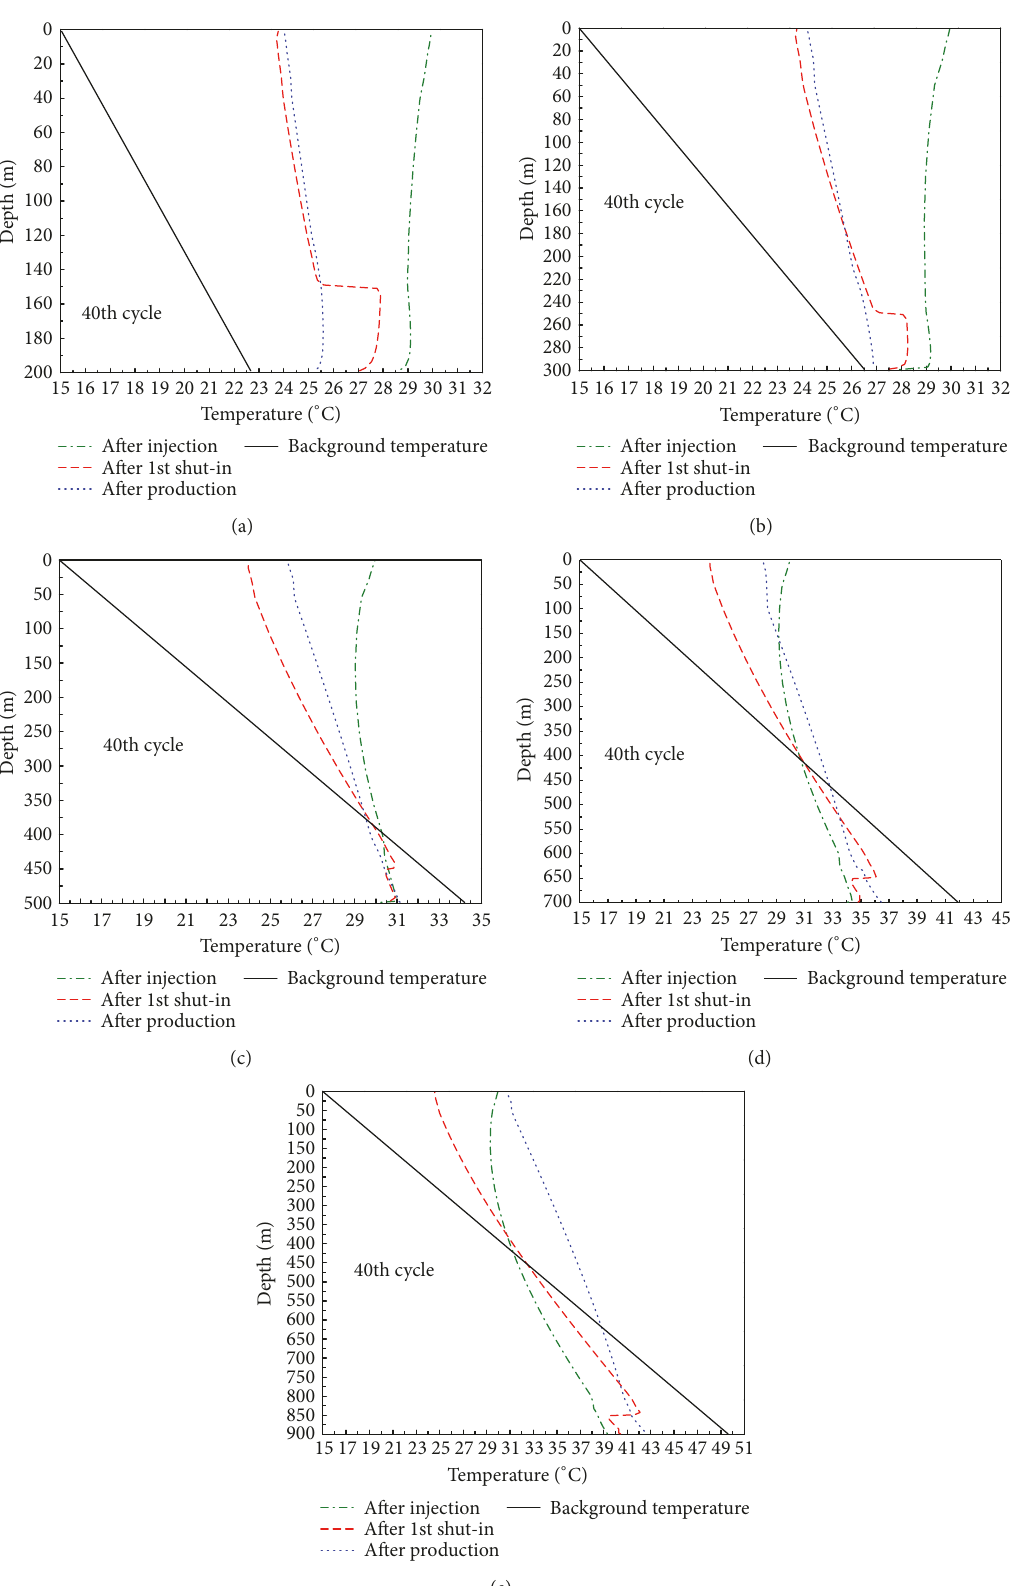
Figure14:Thetemperatureprofilesalongthewellboreinthe40thcycleforthedifferentcases.(a)Case 4 (150–200 m);(b)Case 5 (250–300 m); (c) Case 6 (450–500 m); (d) Case 7 (650–700 m); (e) Case 8